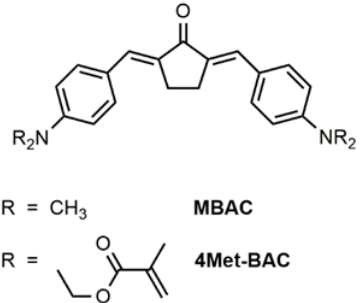
Figure 1. Molecular structure of MBAC and 4Met-BAC photoinitiators.